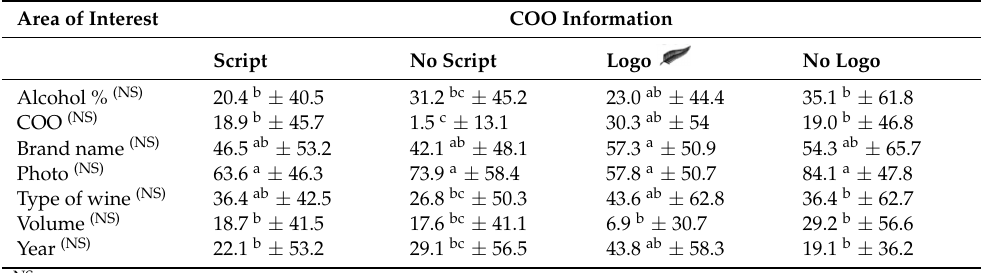
Table 2. Means and standard deviations of the first fixation duration (ms) on each AOI for four labels *. Area of Interest